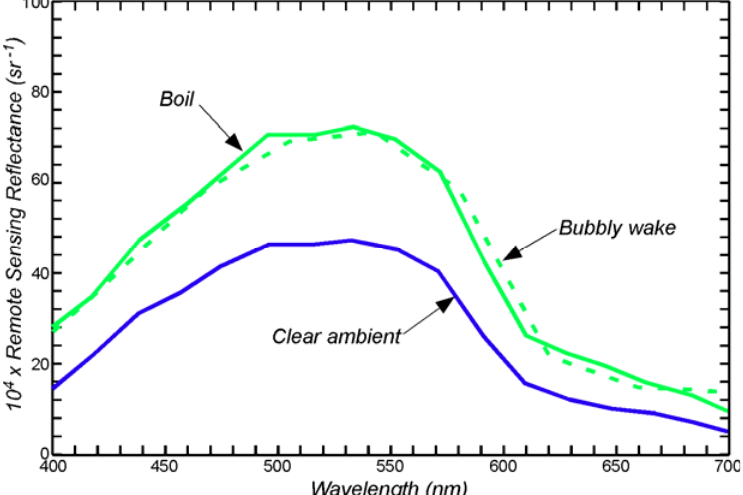
Figure 6. Spectrum from the interior of the boil signatures in Figure 5(c) compared with spectra from ambient water and from the bubbly wake of a large